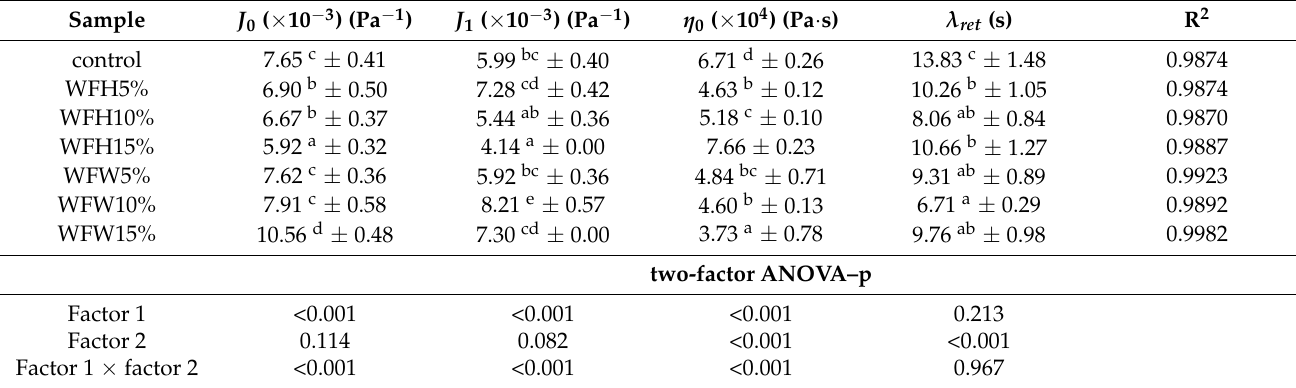
Table 4. Values of the Burgers model parameters for creep and recovery curves of the systems wheat flour with nuts.